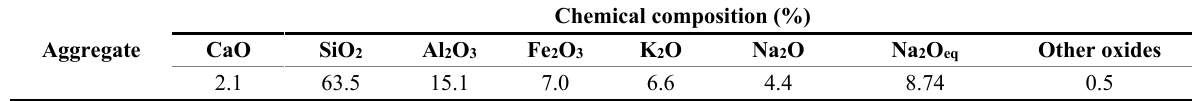
Table 1. Chemical composition (oxides %) of aggregate.